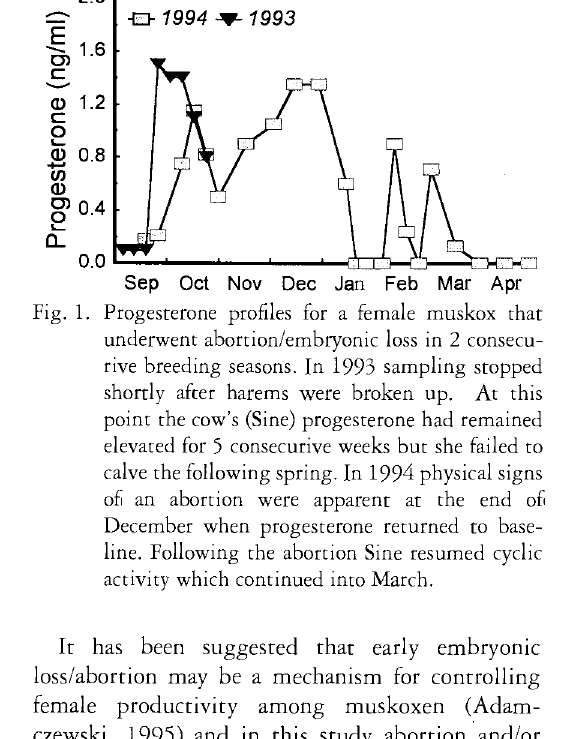
Fig. 1. Progesterone profiles for a female muskox that underwent abortion/embryonic loss in 2 consecu- rive breeding seasons. In 1993 sampling stopped shortly after harems were broken up. At this point the cow's (Sine) progesterone had remained elevated for 5 consecurive weeks but she failed to calve the following spring. In 1994 physical signs of an abortion were apparent at the end of December when progesterone returned to base line. Following the abortion Sine resumed cyclic activity which continued into